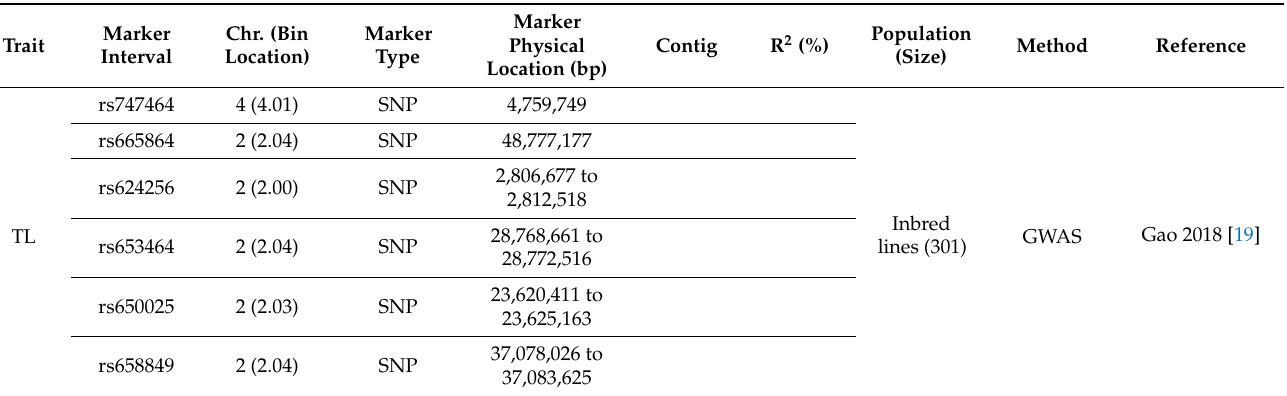
Table 2. Summary of original genetic loci for multiple maize insect-resistant traits of Asian corn borer (ACB) and corn leaf aphid (CLA) from previous